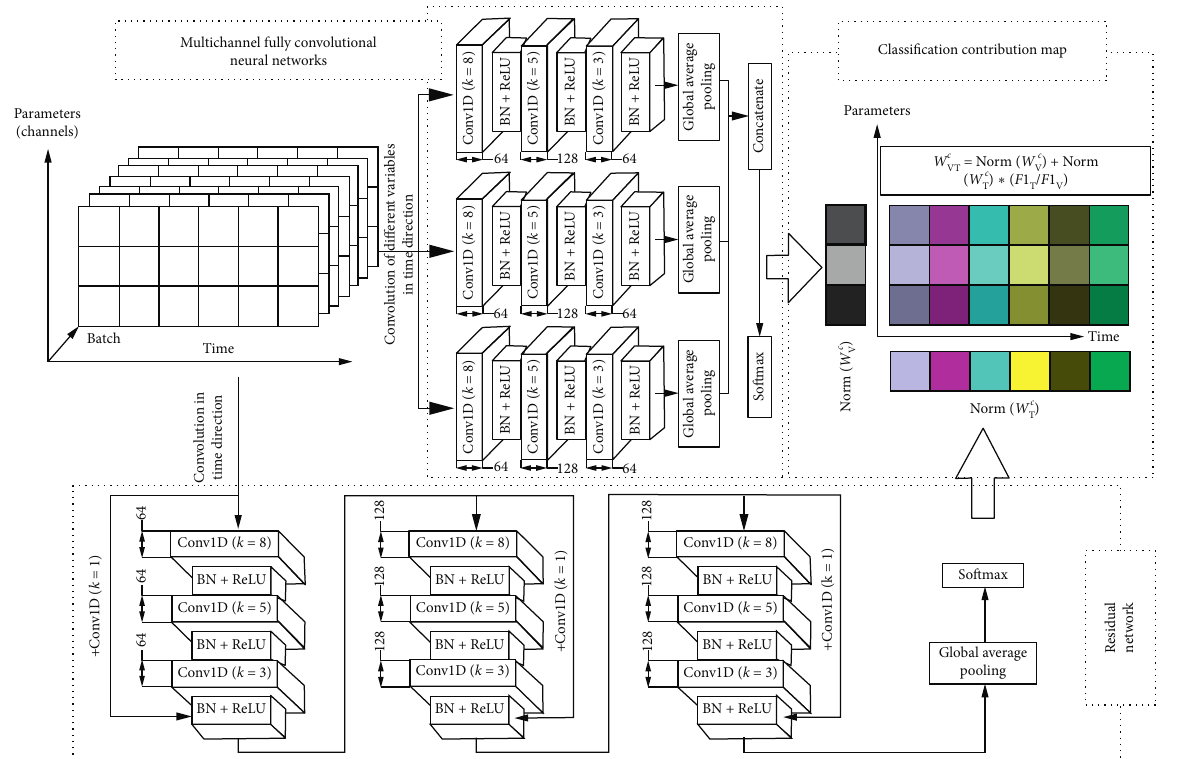
Figure 8: method used to visualize the classification features of the